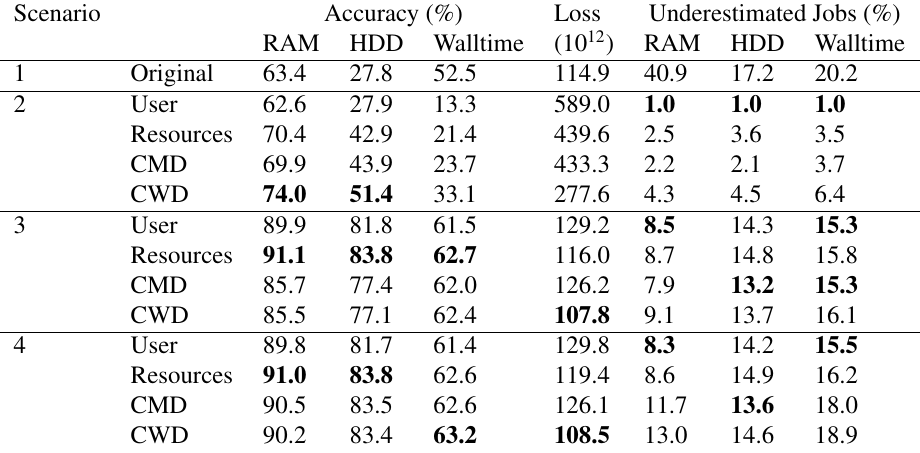
Table 2. Detailed statistics for original request and clustering in the ETP dataset when using the ideal sliding window per user, determined on 80% of each user’s jobs, combined with the use of the local and global user profile to make predictions for new users or new workflows. Lower values for the rating and percentage of underestimated jobs and higher values for accuracy are better.